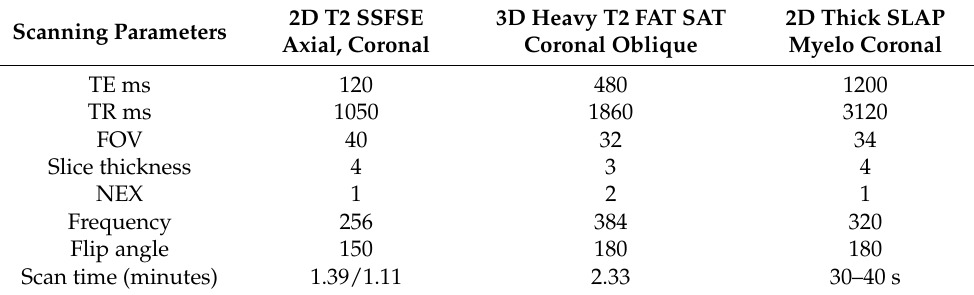
Table 1. Scanning parameters of MRCP. Scanning